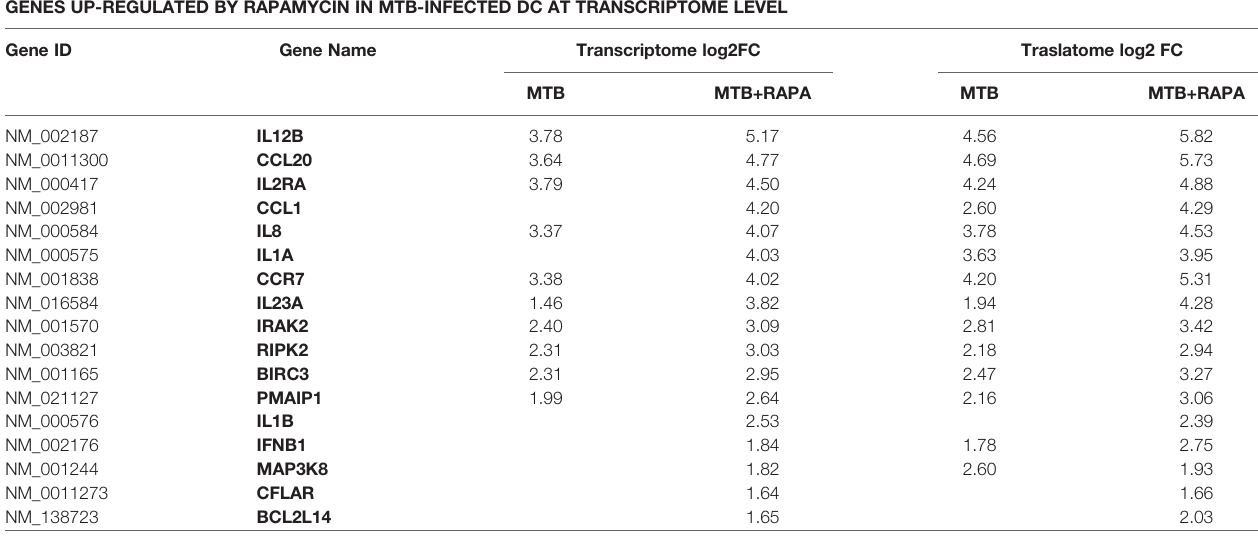
TABLE 2 | List of top genes de-regulated at the transcriptome level in human DC after Mtb infection and rapamycin treatment. GENES UP-REGULATED BY RAPAMYCIN IN MTB-INFECTED DC AT TRANSCRIPTOME LEVEL Gene ID